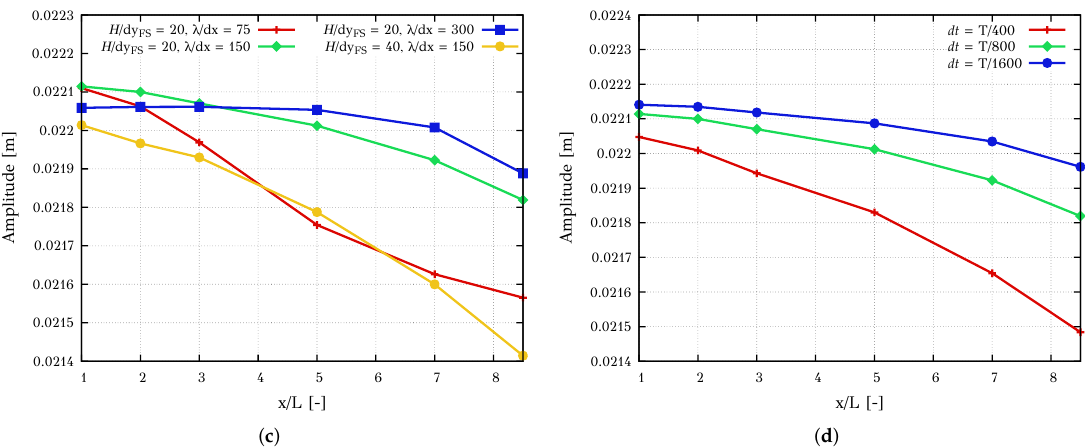
Figure 5. Grid and Timestep independence study. Wave characteristics: T = 5 s, H = 0.05 m, d = 0.5, λ = 11.08 m. ( a ) Grid Independence: Wave elevation 5 wave lengths after the wave generation zone; ( b ) Grid Independence: Wave elevation at a station 5 wave lengths after the wave generation zone. The snapshot is after 25 wave periods; ( c ) Grid Independence: Amplitude of the 1st harmonic of the wave at various grid locations; ( d ) Timestep Independence: Amplitude of the 1st harmonic of the wave at various grid